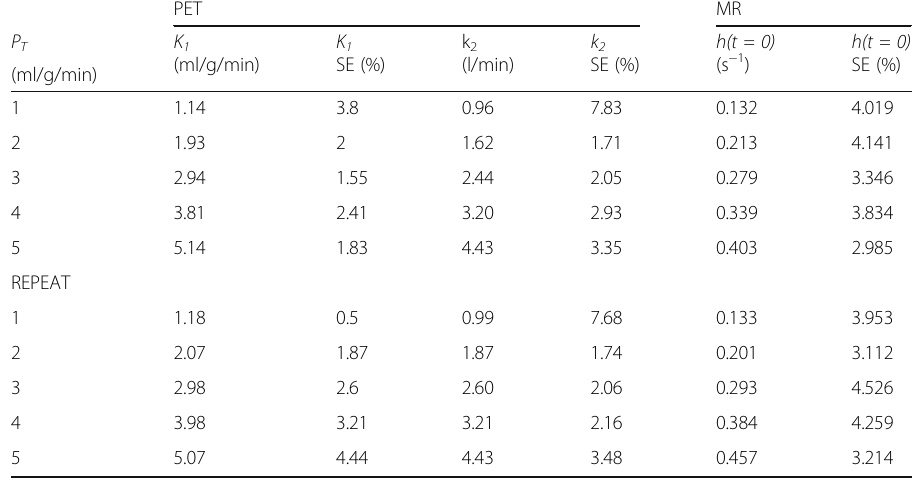
Table 1 Results of employing a one compartment kinetic model to the PET and deconvolution model to the MR data (Eq. 1)